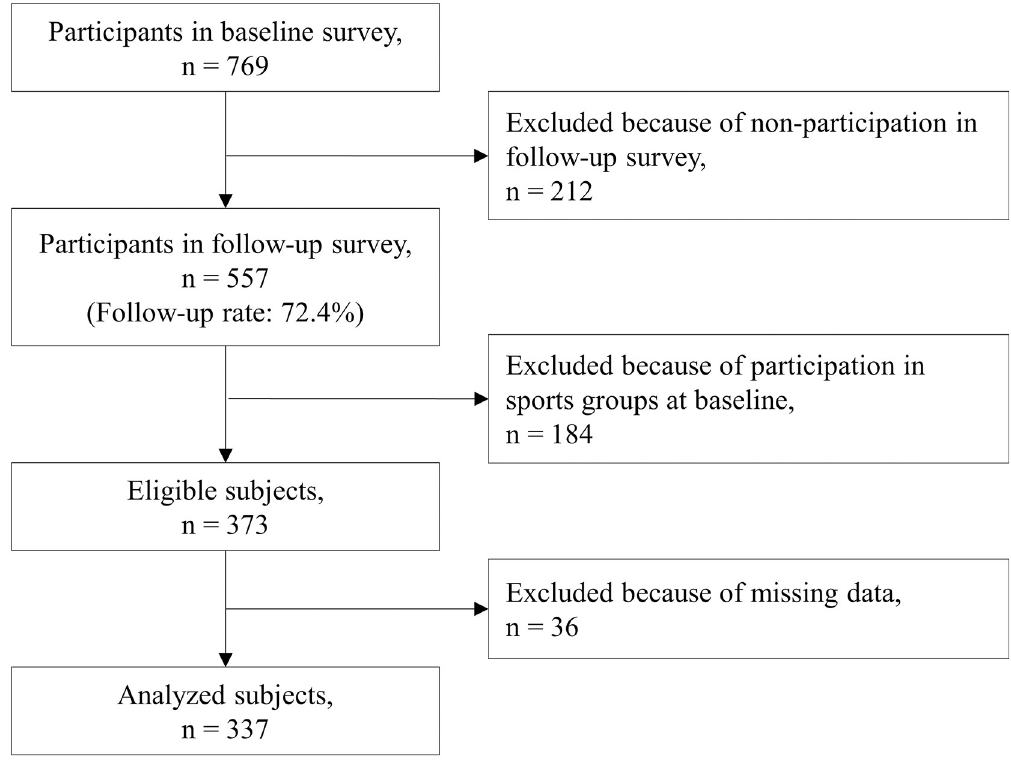
Fig 1. Flow diagram of enrollment of study